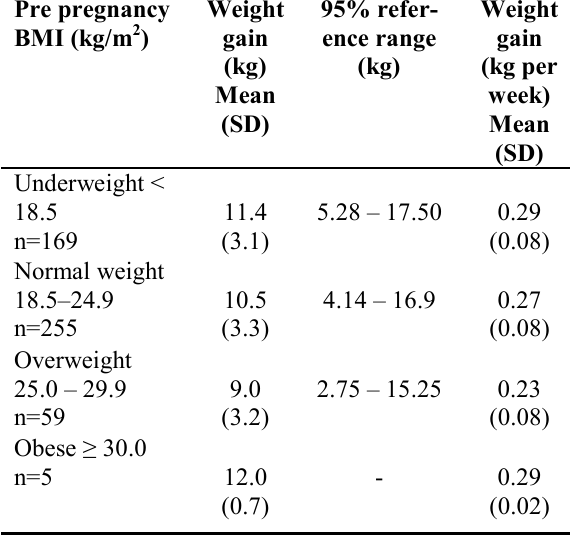
Table 4 – Gestational weight gain pattern in the total sample, by Asians pre-pregnancy